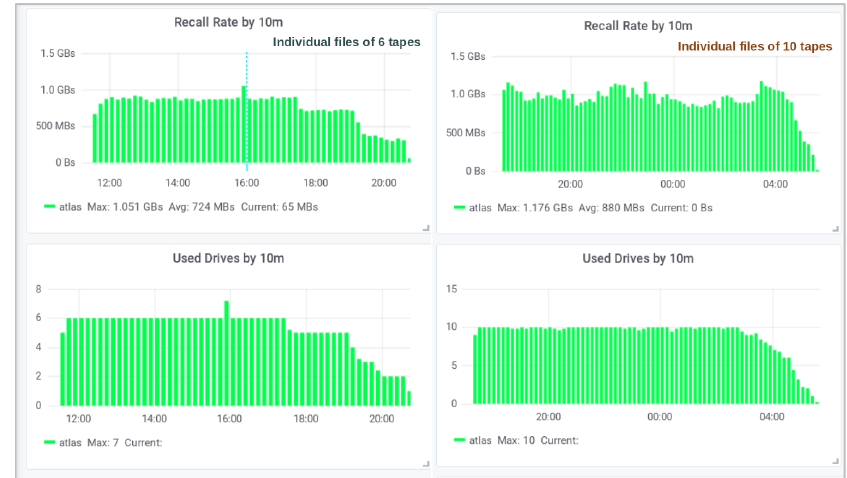
Figure 5: Read individual files from tapes (6 and 10 tape